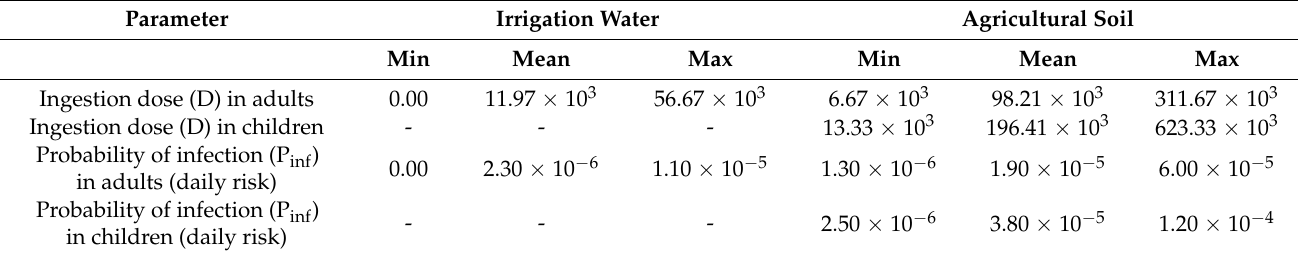
Table 3. The daily probability of infection based on hazard characterization in irrigation water and agricultural soil